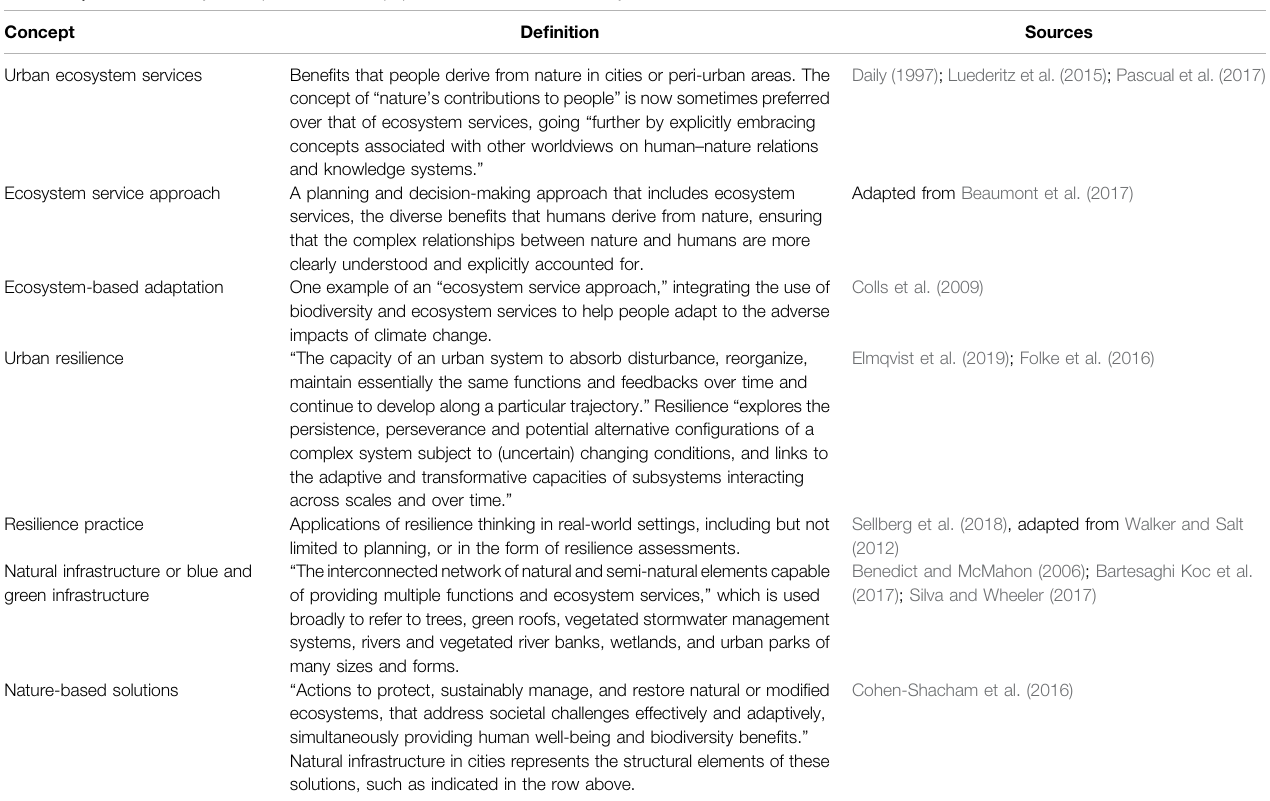
TABLE 1 | De fi nition of key concepts used in this paper in the context of urban